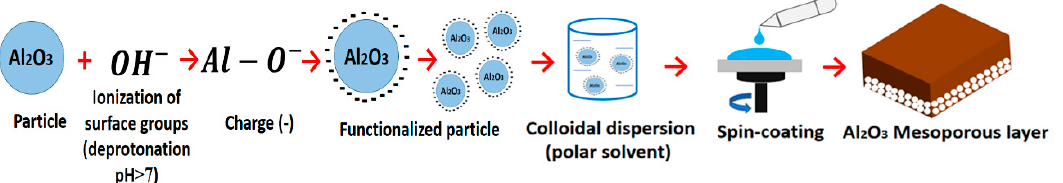
Figure 1. Alumina dispersion preparation process and spin-coating technique for the manufacture of the mesoporous layer. Table 2. Parameters for alumina dispersion preparation and manufacture of mesoporous layer.